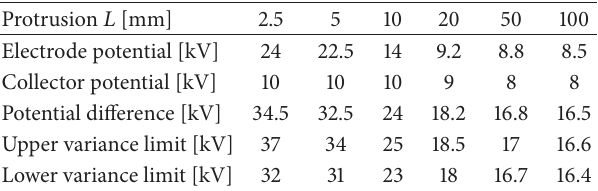
Table 1: Measured values of critical